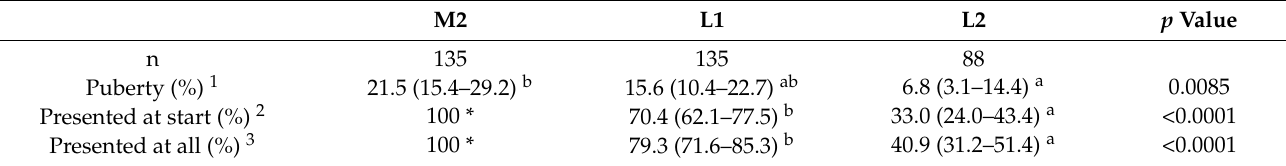
Table 1. Percentage of ewe lambs showing oestrous (as an indicator of puberty) prior to the introduction of the ram (Puberty; %), presented for breeding at the start of the breeding period or added to the breeding group for the second half of the breeding period (34 days) for ewe lambs born as twins to mature ewes (M2) or born to ewe lambs as singletons (L1) or as twins (L2) during their first breeding. Values are back-transformed LS means and 95% confidence intervals.